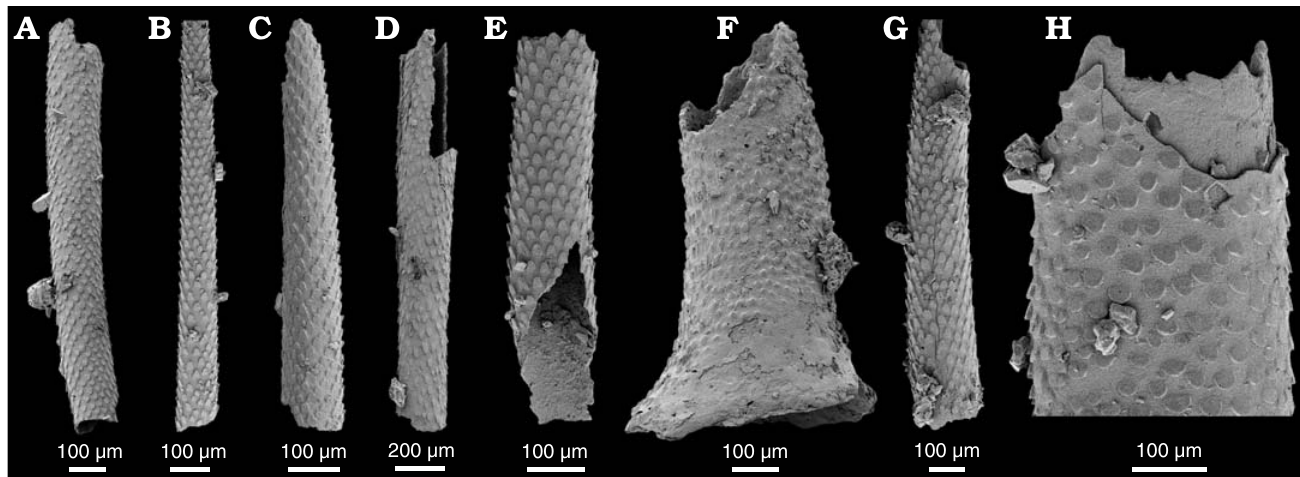
Fig. 5. Spines of the bradoriid arthropod Mongolitubulus squamifer Missarzhevsky, 1977 from the lower Cambrian White Point Conglomerate, Kangaroo Island, South Australia. A . SAM P57227. B . SAM P57228. C . SAM P57229. D . SAM P57230. E . SAM P57231. F . SAM P57232, fragment with flared base. G . SAM P57233. H . SAM P57234, close-up of rhomboid